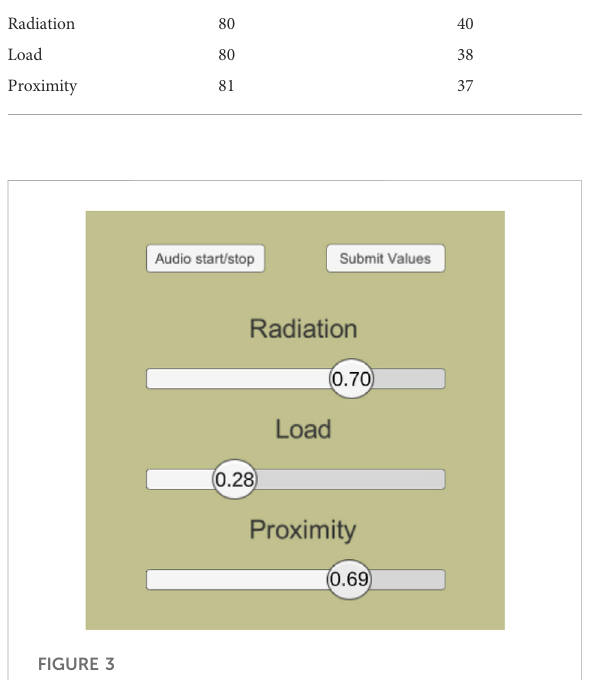
FIGURE 3 The user interface for the sound set evaluation study.